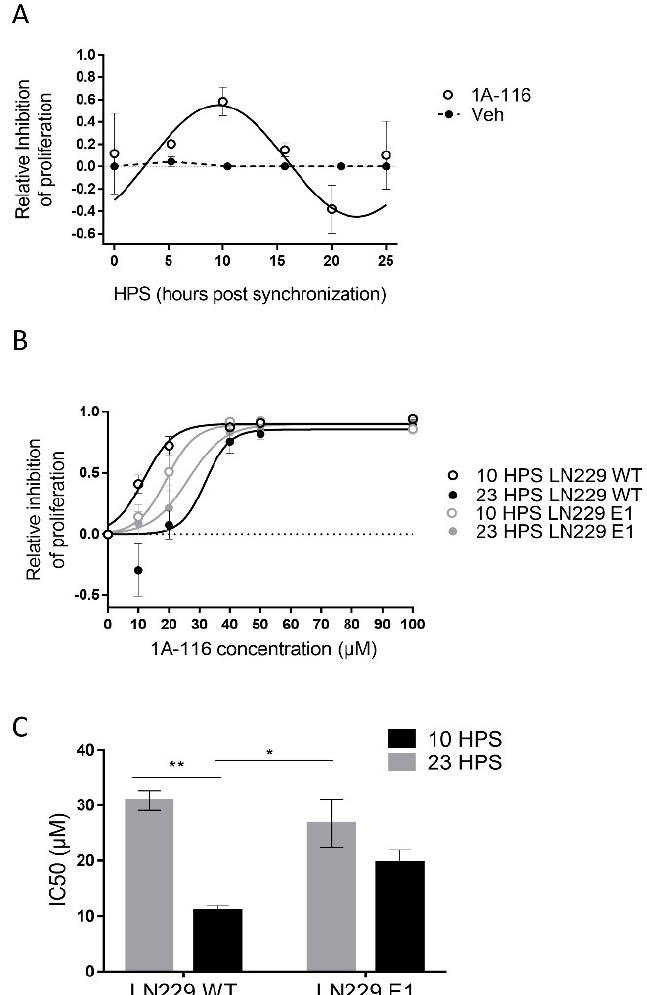
Figure 2. Circadian variation in the effect of 1A-116 on proliferation in the LN229 glioblastoma cell line. ( A ) Proliferation inhibition relative to vehicle-treated cells. The assessment was conducted with crystal violet 0.1% staining, 72 h after applying the treatment of 20 µ m of 1A-116 or vehicle at different HPS. Circadian modulation of 1A-116 effects on proliferation was observed with significant values when fitting to a fix 24 h period: Meta2d: p < 0.01, two-way ANOVA, ns. ( B ) Dose–response curves for proliferation inhibition relative to vehicle-treated cells in LN229 and LN229E1 cultures, which were treated at 10 HPS or 23 HPS (mean ± SEM). A larger response was observed when LN229 was treated at 10 HPS; Three-way ANOVA: HPS, p < 0.0001; 1A-116 Concentration, p < 0.0001; 1A-116 Concentration × HPS, p < 0.0002; HPS × Cell type, p < 0.0041; 1A-116 Concentration × HPS × cell type, p < 0.05, N = 3. Only main comparisons are stated for results obtained with Tukey ´ s multiple comparisons test: LN229 WT 10 HPS 10 µ M vs. LN229 WT 23 HPS 10 µ M, p < 0.0001, LN229 WT 10 HPS 20 µ M vs. LN229 WT 23 HPS 20 µ M, p < 0.0003; LN229 WT 10 HPS 20 µ M vs. LN229E1 23 HPS 20 µ M, p < 0.013, LN229 WT 10 HPS 0 µ M vs. LN229 WT 10 HPS 20 µ M, p < 0.0001, LN229E1 10 HPS 0 µ M vs. LN229E1 10 HPS 20 µ M, p < 0.026). The dose-response curves were obtained by fitting the median data values, which were calculated from three separate experiments. ( C ) IC50 values were obtained for independent experiments. It shows significantly lower IC50 values for LN229 cultures treated at 10 HPS. No time dependency was found for LN229E1. The following values were obtained: Two-way ANOVA, for factor HPS, p < 0.001, HPS x cell line, p < 0.05. Tukey’s multiple comparisons test reported: 10 HPS LN229 vs. 23 HPS LN229 ** p < 0.01,10 HPS LN229 vs. 23 HPS LN229E1, * p < 0.05. All plotted data represent mean ±